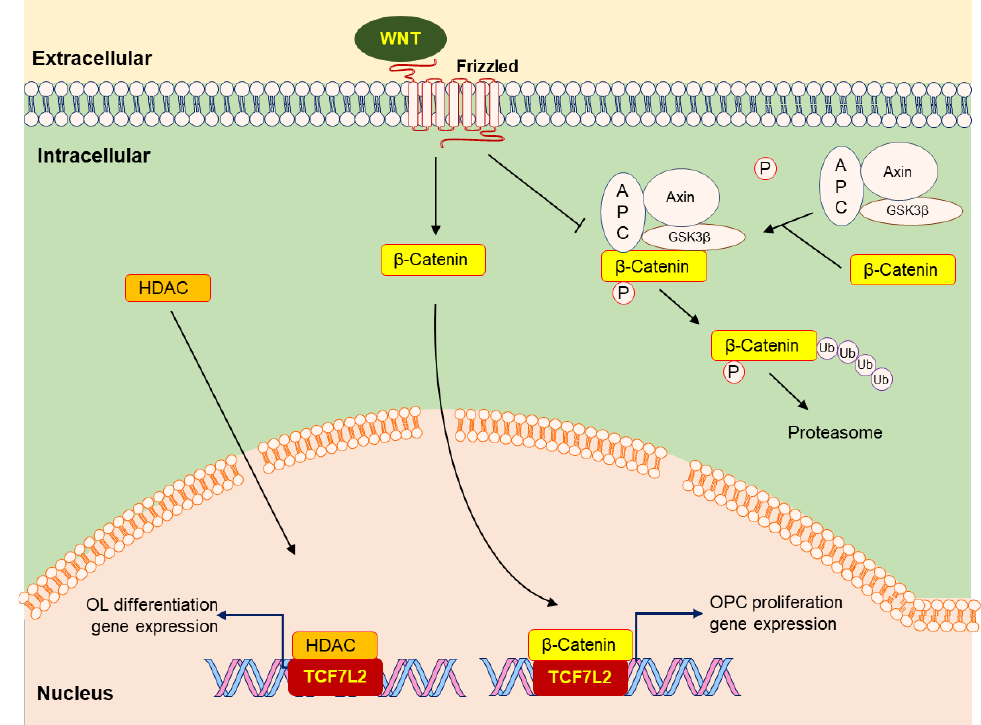
Figure 2. The role of the Wnt signaling pathway in OPC proliferation and OL differentiation. β - Catenin is the crucial effector in the canonical Wnt signaling pathway. When the WNT is absent, β -Catenin is phosphorated by GSK3 β in the complex, and the phosphorylation is the signal for ubiquitination, leading to the digestion of β -Catenin. After WNT is activated, β -Catenin in the free state enters the nucleus and promotes OPC proliferation via binding with TCF7L2. HDAC may compete with β -Catenin to interact with TCF7L2 and switches TCF7L2 from an inhibitor to an activator in OL